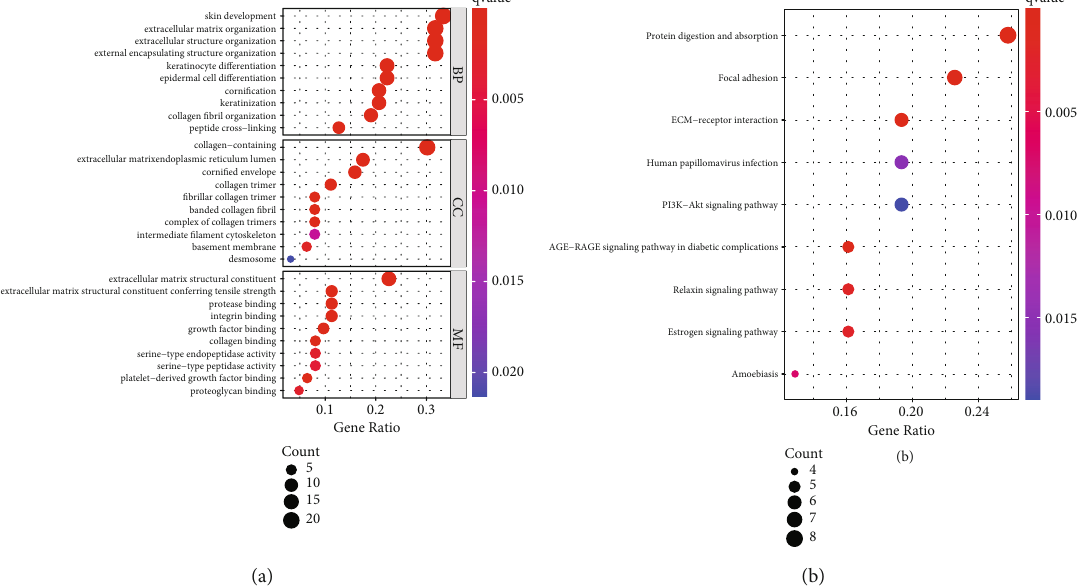
Figure 6: GO and KEGG assays were performed to explore the possible function of the dysregulated genes in CC. (a) BP, CC, and MF in GO enrichment analyses. (b) The top 30 enriched KEGG